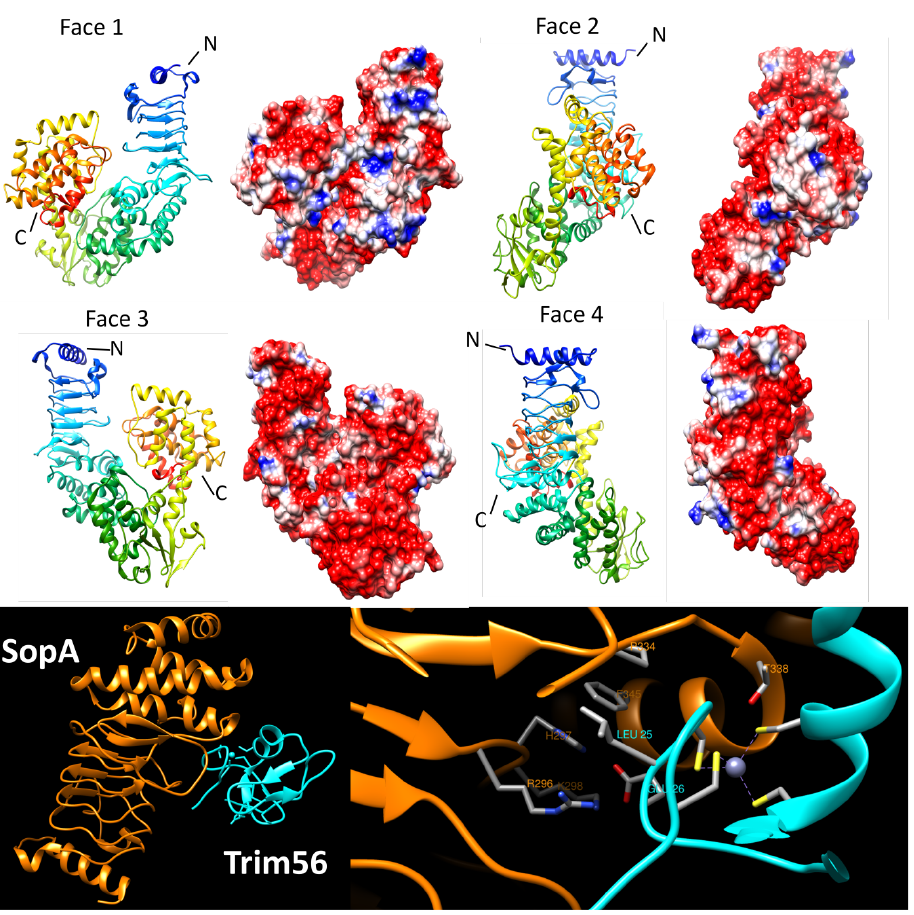
Figure 10. Structure and analysis of SopA. The top panel shows ribbon diagrams of the structure (PDB ID: 2QZA) for four different orientations (at left) and the corresponding electronic potential surface plots (at right). The bottom panel (left figure) shows the overall interaction between SopA and Trim56 (5JW7) and the right figure shows the details of the interaction. SopA is colored orange and Trim56 is colored